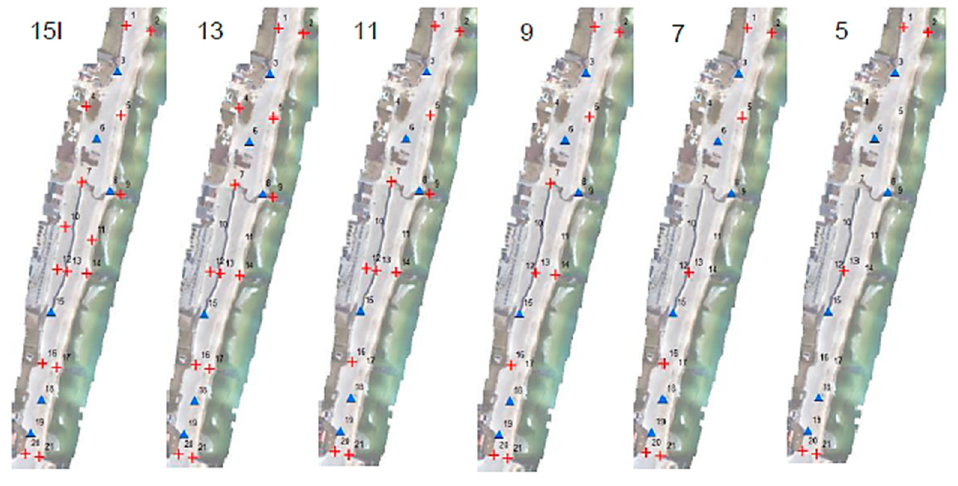
Figure 10. Configurations of the different amounts of GCPs tested on variation I (GCPs (+) and check points ( ▲ )).